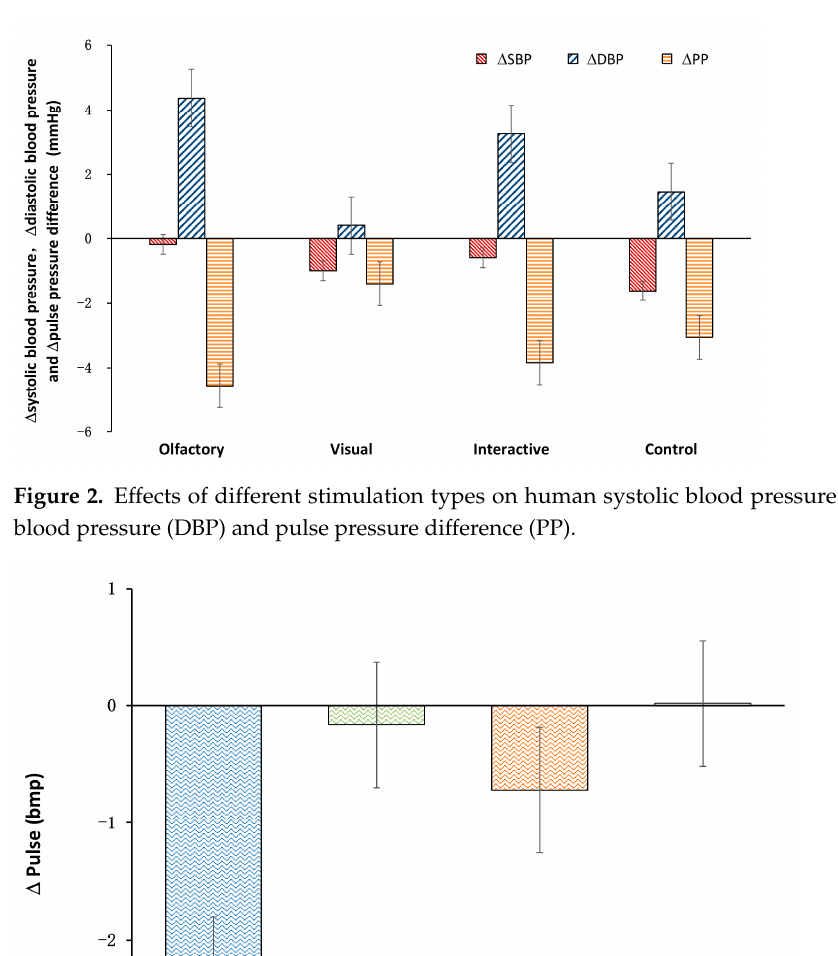
Figure 3. Effects of different stimulation types on human pulse (P).